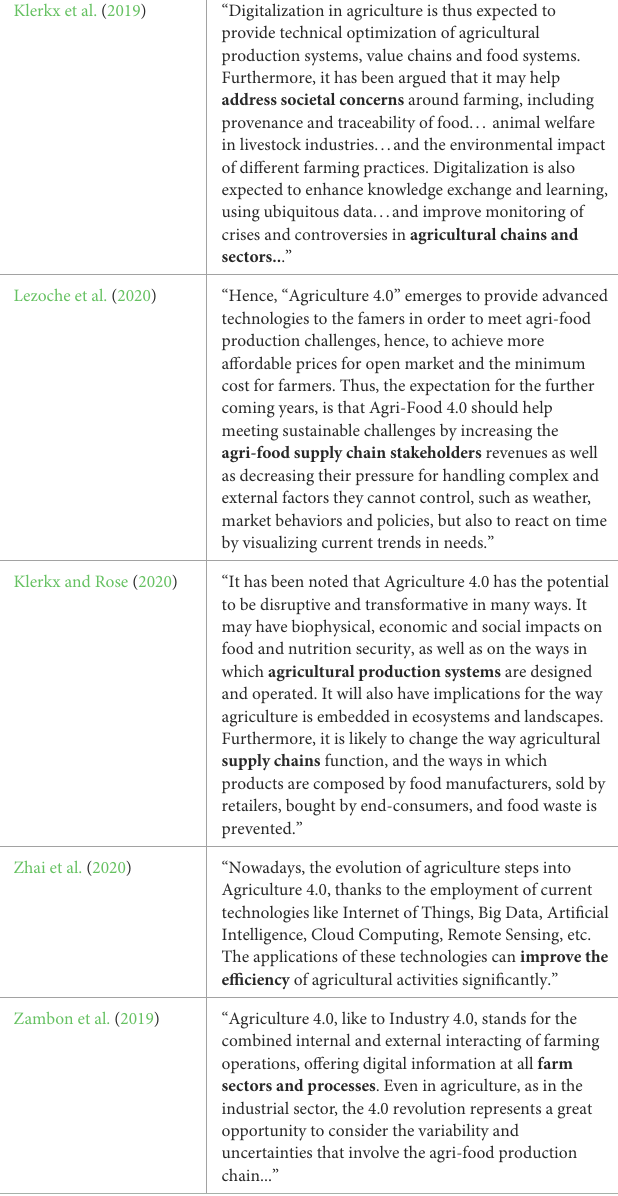
TABLE 2 Definitions of digital agriculture from the top-five cited papers found through the literature search. Klerkx et al.